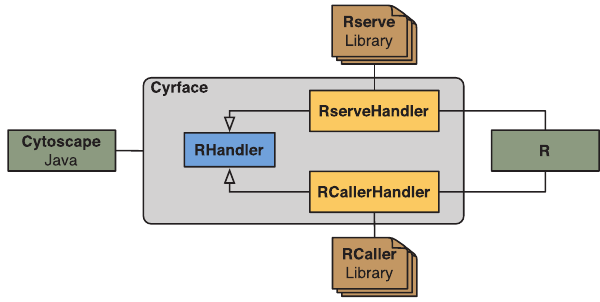
Figure 1. Diagram of the Cyrface interaction layer with R. Within the grey box the class hierarchy of the classes responsible